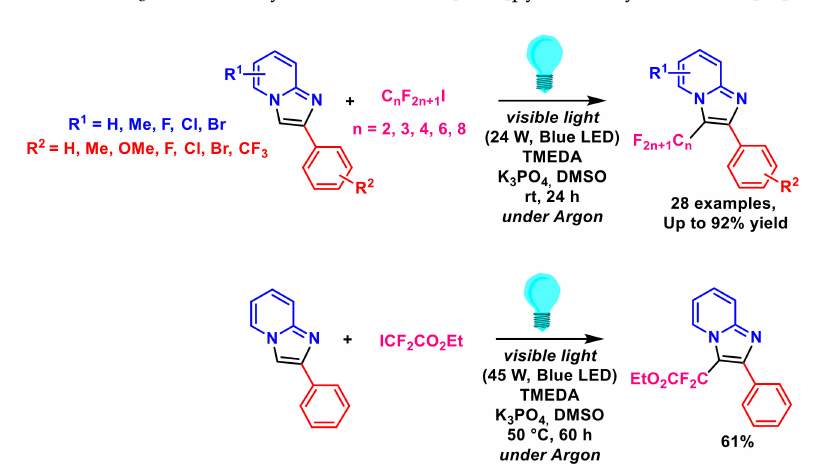
To enlarge the diversity of fluorinated imidazopyridines, the Fu team conceived access to (phenylsulfonyl) difluoromethylated structures in the presence of PhSO 2 CF 2 I, K 2 CO 3, and fac -[Ir(ppy) 3 ] [43]. The adopted protocol allowed for the preparation of 15 C 3 - functionalized imidazo[1,2- a ]pyridines with good-to-high yields (Scheme